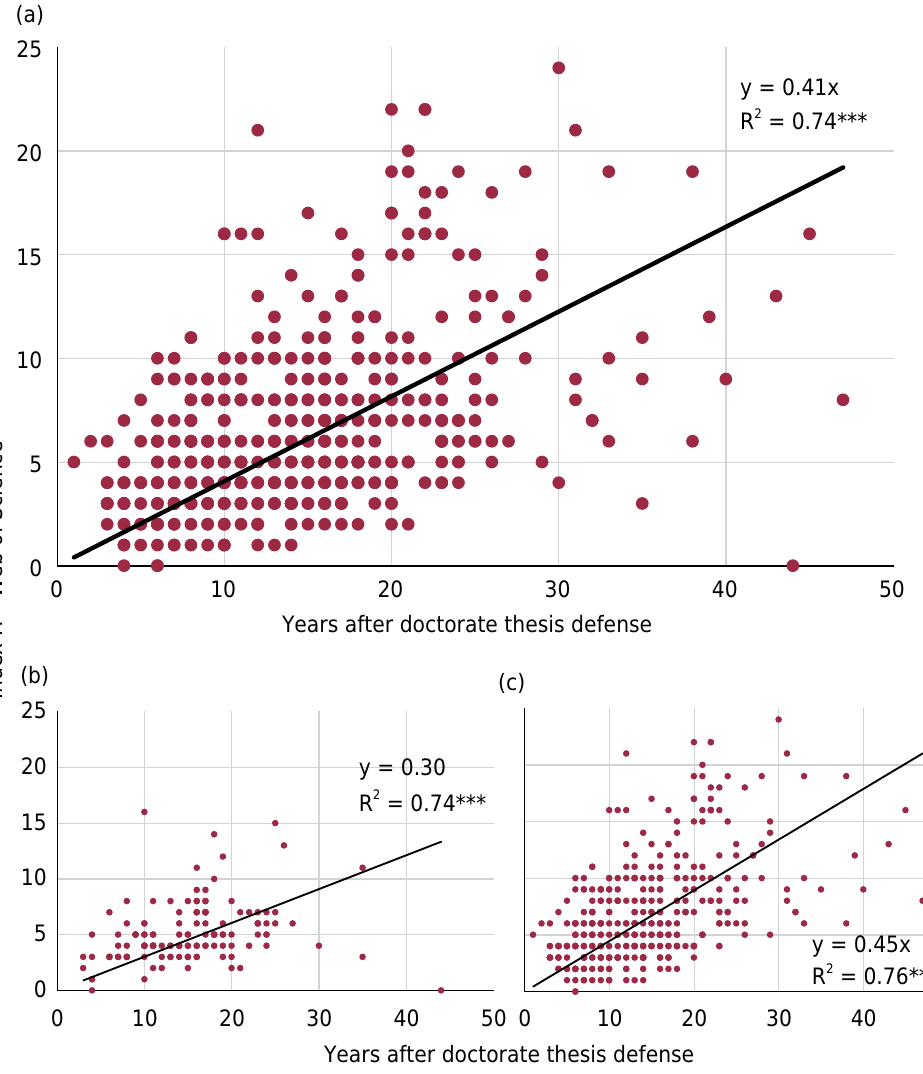
Figure 2. H-index of the Web of Science (H-WoS) of researchers, as a function of the number of years after the end of the doctoral degree, for all researchers, regardless of gender (a) and by gender women (b) and men (c), in CNPq Call